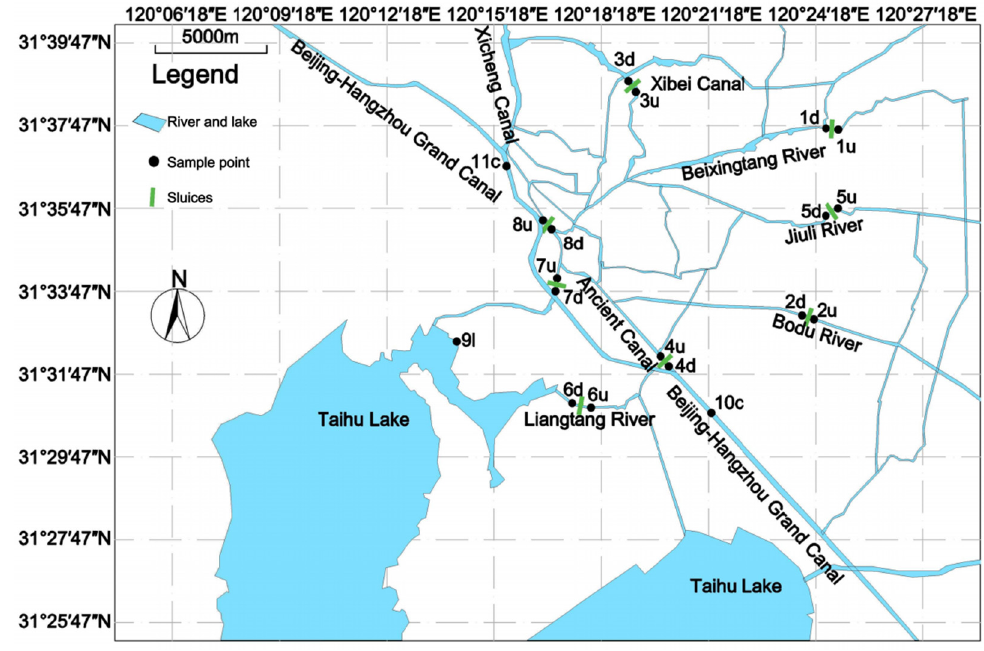
Figure 1. Research area and sample